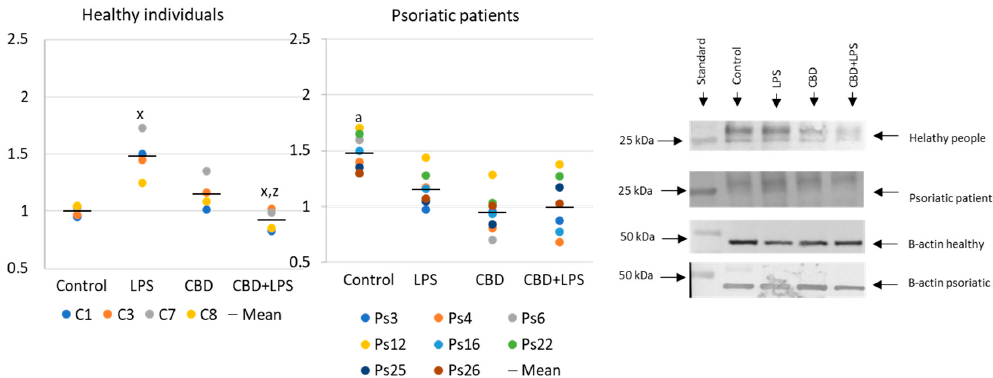
Figure 5. Neutrophil elastase expression in human neutrophils from heathy subjects ( n = 4) and psoriatic patients ( n = 8) after 1 h incubation with LPS, cannabidiol and LPS with cannabidiol. a—statistically significant difference between neutrophils from patients with psoriasis vulgaris and healthy subjects p < 0.05; x—statistically significant difference between treated neutrophils (with LPS, CBD, or LPS + CBD) and non-treated (control) cells; p < 0.05; z—statistically significant difference between neutrophils treated with LPS + CBD and treated only with LPS; p < 0.05.